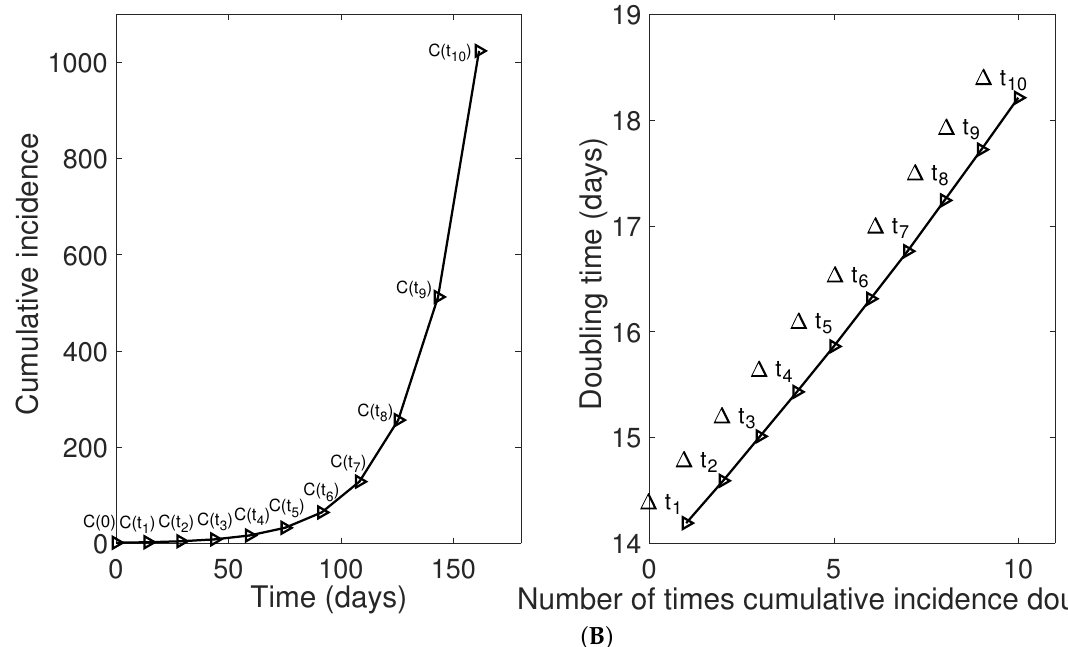
Figure 1. ( A ) Illustration of the temporal evolution of cumulative incidence and times t i , such that 2 C ( t i ) = C ( t i + 1 ) , at which cumulative incidence doubles, and ( B ) the actual sequence of “doubl-ing times”, where ∆ t i = t i − t i − 1 , i = 1, . . . , n d . In this illustration the doubling times increase as cumulative incidence doubles, indicating that the epidemic features sub-exponential rather than exponential growth